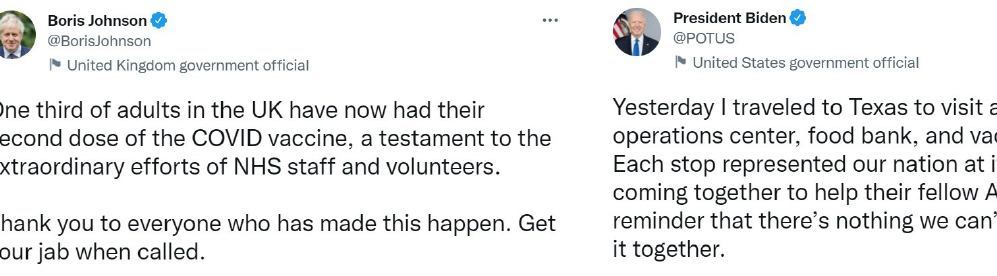
Figure 1. Examples of issue frame (vaccination data) and game frame (political strategy